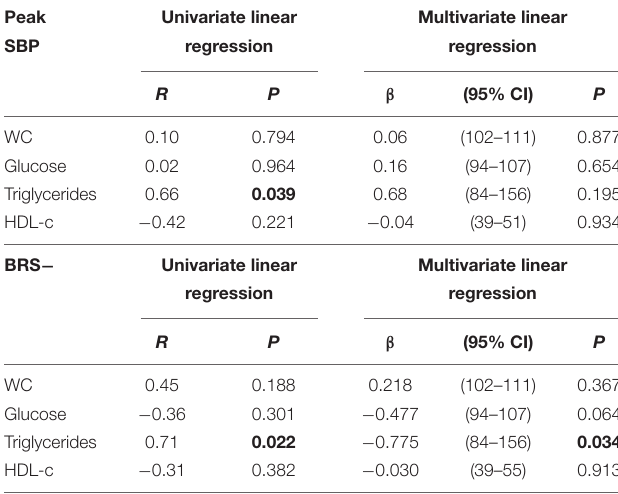
TABLE 5 | Univariate and multivariate linear regression between peak SBP and metabolic risk factors and between BRS − and metabolic risk factors in the MetS_NT subgroups with EEBP (MetS_NT + ) during maximal